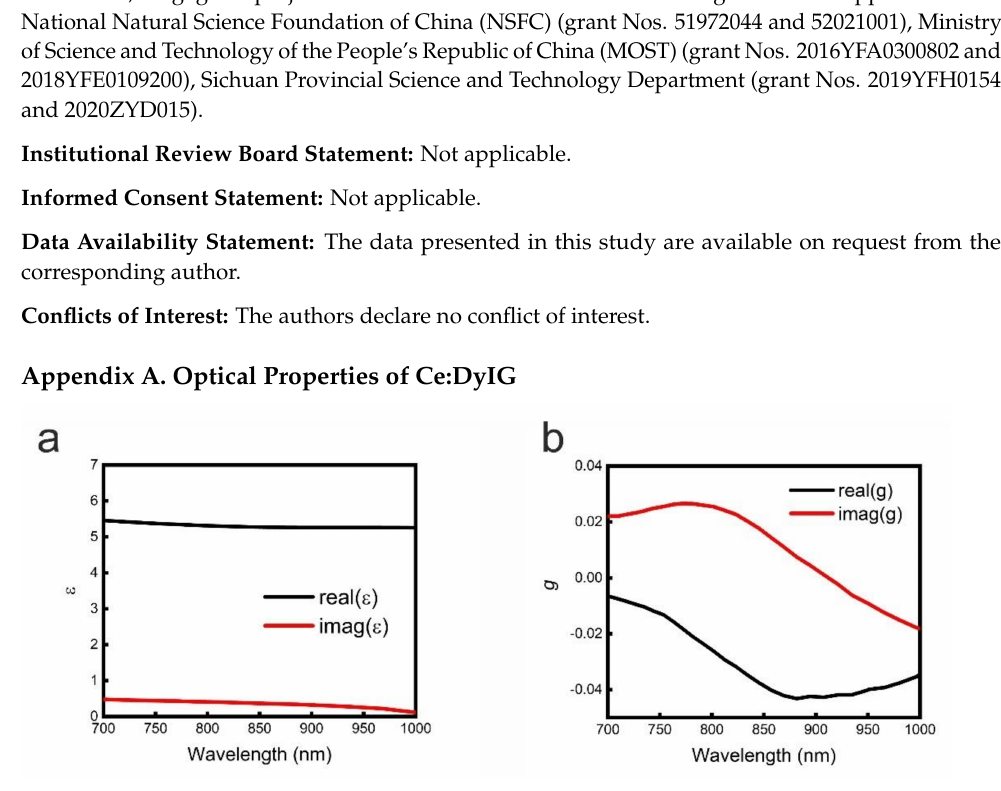
Figure A1. Dielectric permittivity ( a ) and gyration ( b ) of Ce:DyIG.